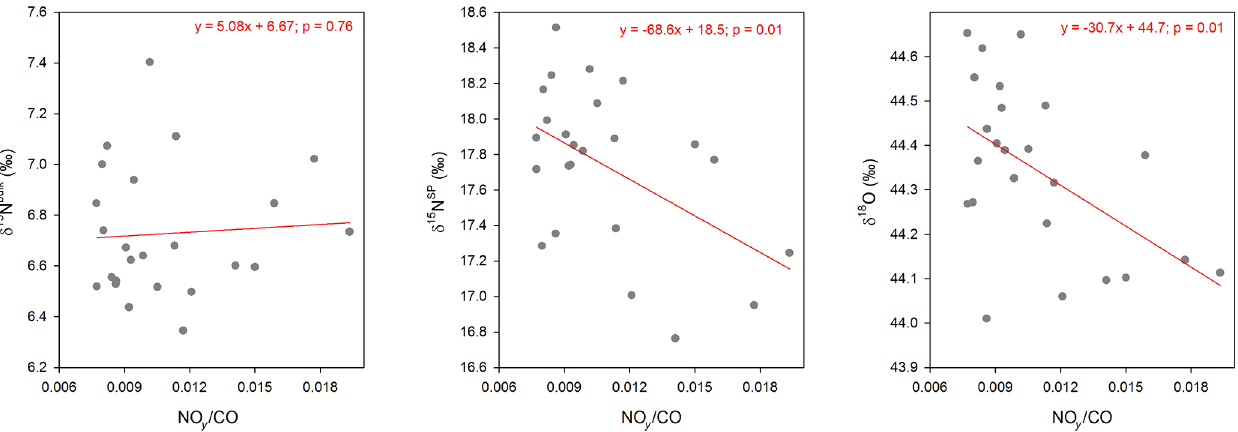
Figure 8. Relationship between the NO y to CO ratios and isotopic signatures of N 2 O; only data points with NO y / CO > 0.007 are presented here (which refer to scenarios with strong pollution from local